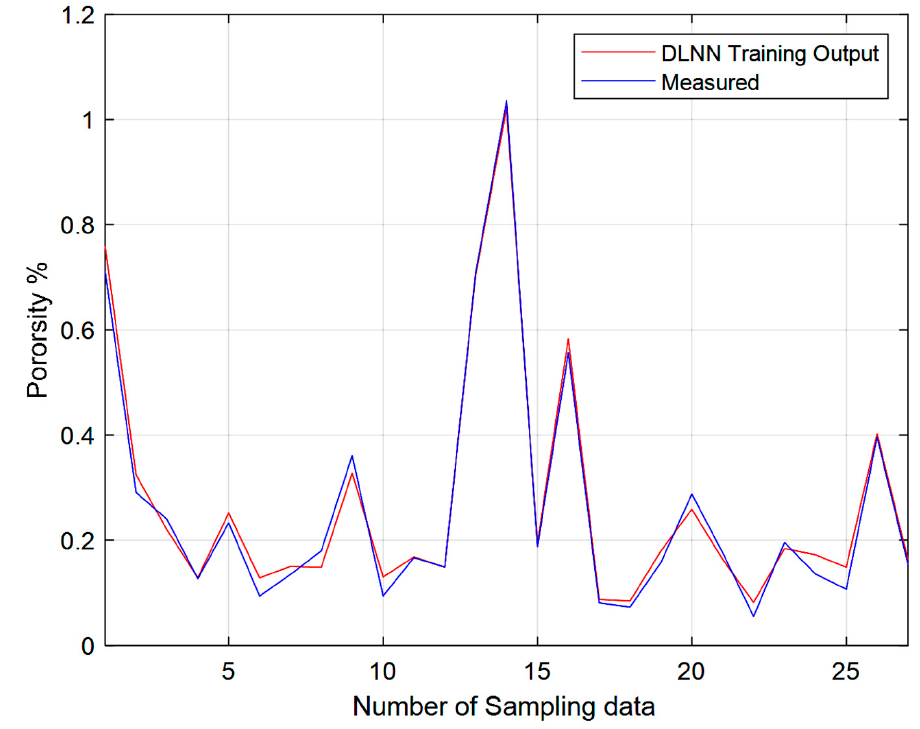
Figure 6. Measured porosity compared to the output of the DLNN model.